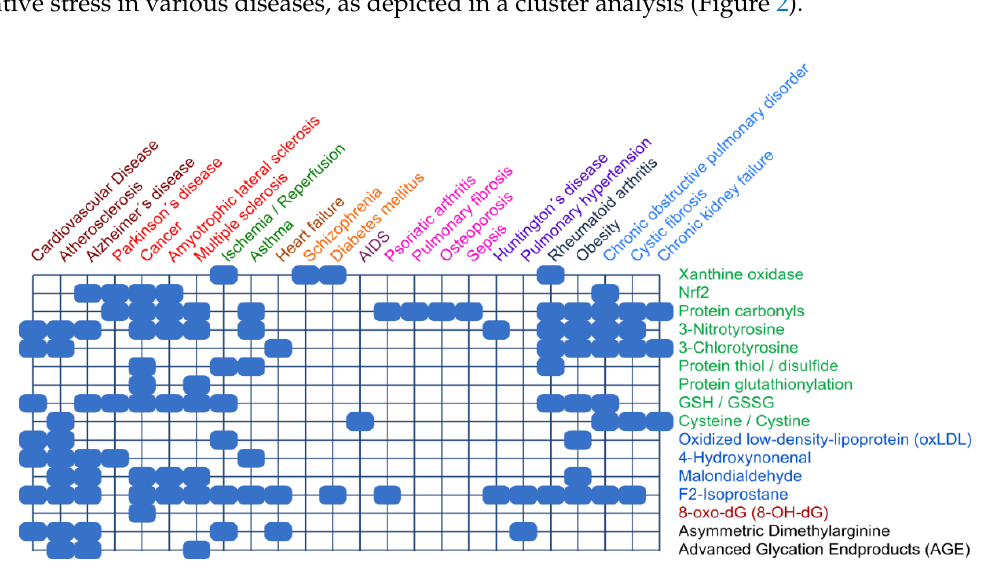
Figure 2. Clinical relevance of biomarkers of oxidative stress. Color coding on right: Protein (green), lipid (blue), and DNA (red) biomarkers are analyzed for various diseases. Color coding on top: results from cluster analysis. Data compiled from Frijhoff et al. [26], presented as Figure 11 in Ref. [5], with permission.